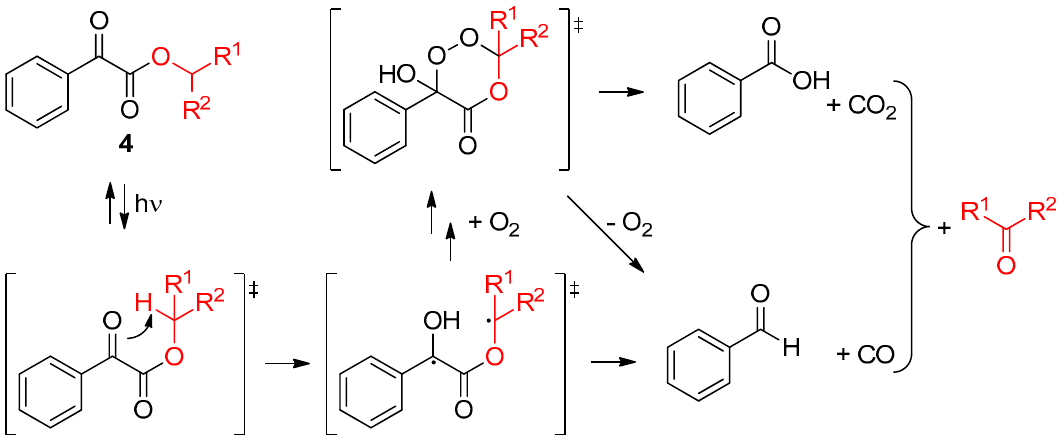
Figure 4. Mechanism of photorelease in profragrances 4 through a Norrish type II photofragmentation. The precursor of the aldehyde- or ketone-based scent is highlighted. The original results were reported by Herrmann and coworkers [31].